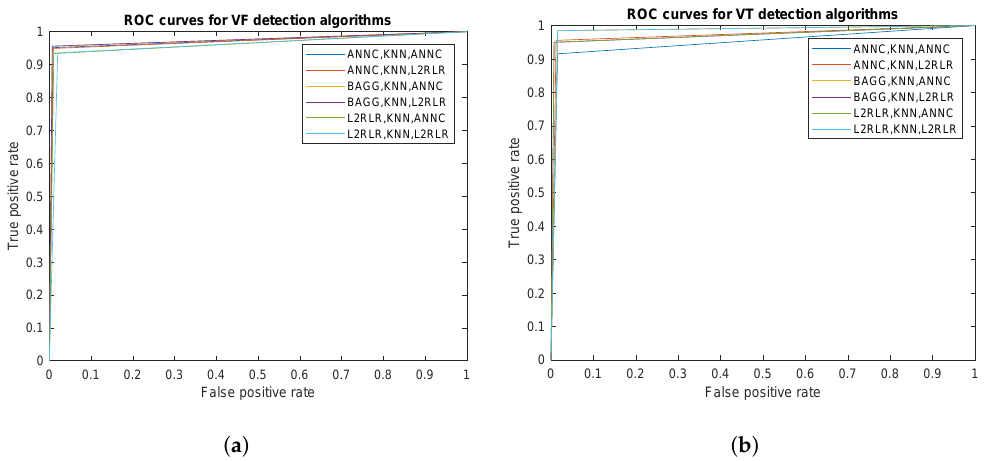
Figure 7. Receiver operating characteristic (ROC) curve for voting majority method (VMM) combination methods in detection of VF ( a ) and VT ( b ).